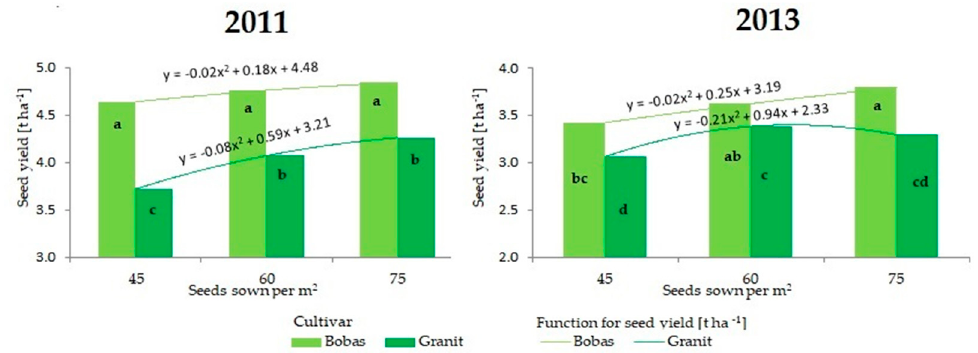
Figure 9. Seed yield in 2011 (SDH × SDY). Different letters indicate significant differences between factors (Tukey’s multiple range test).